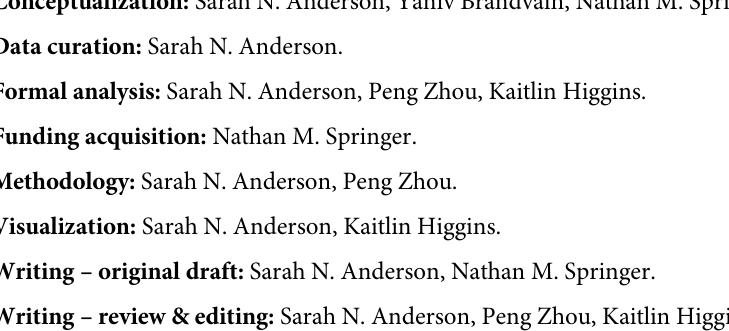
S4 Data. Summary table for features of B73 genes and TEs used in this